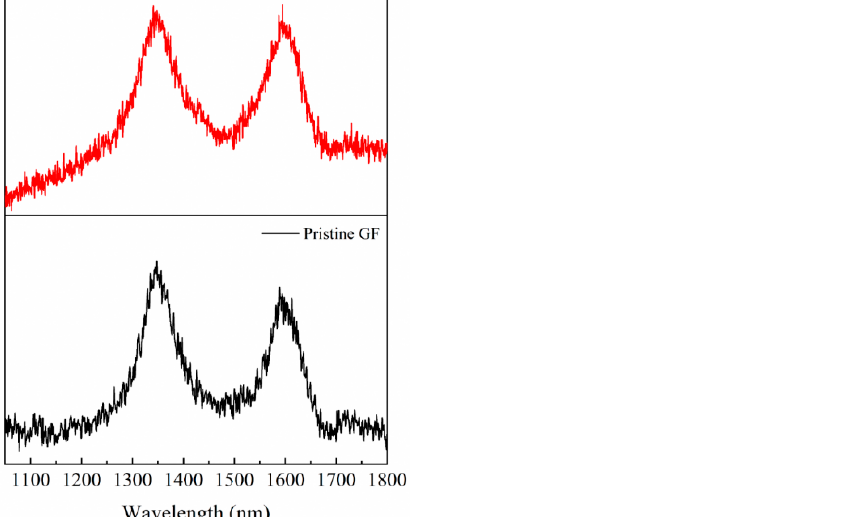
Figure 5. Raman spectrum of pristine GF and APPJ-coated polydopamine on GF.